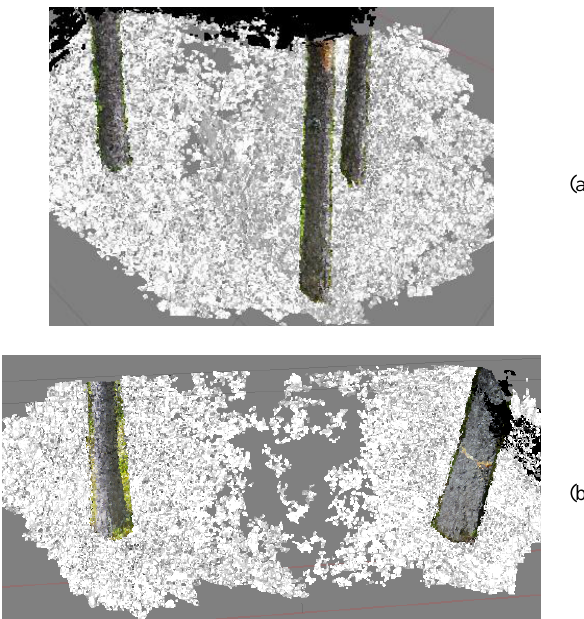
Figure 7: Stem models created with the 3D point clouds: (a) right side and (b) left side.